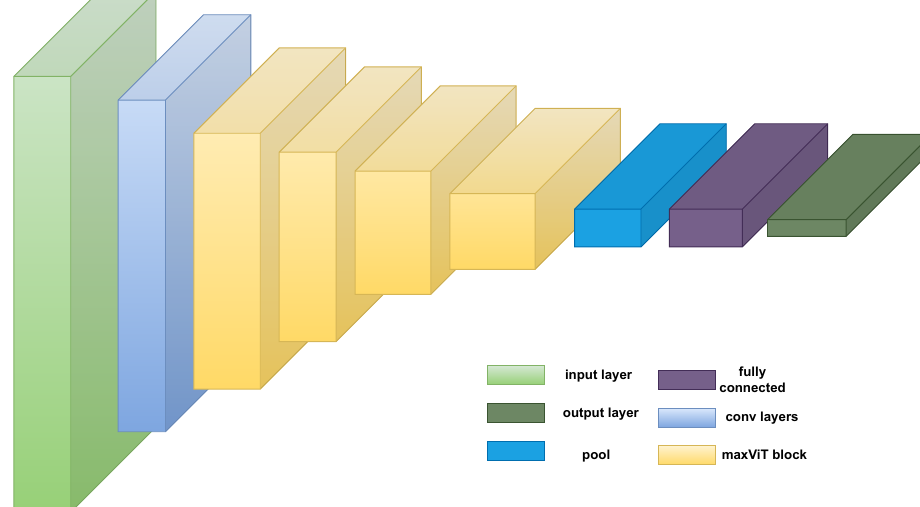
Figure 4. MaxViT architecture [32]. Note that this model uses both local and global mechanisms via the maxViT block.